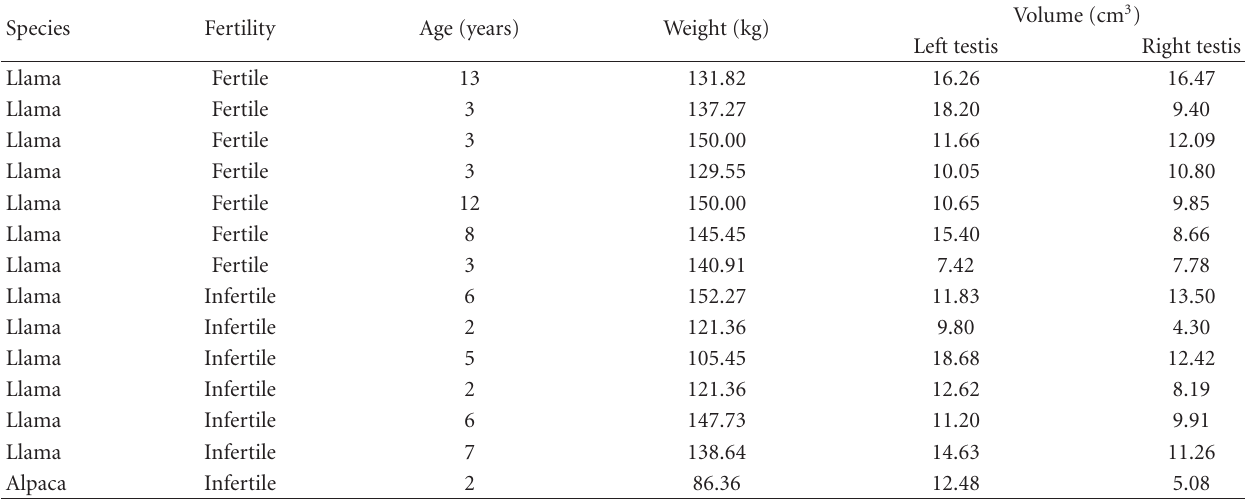
Table 1: Animal information gathered regarding fertility status, age (years), body weight (kg), and testicular volume (cm 3 ) for fourteen camelids used in this study.